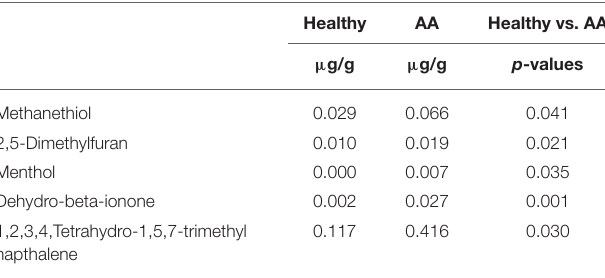
TABLE 2 | Concentrations of VOMs ( µ g/g) in urine samples detected in alopecia areata patients compared to healthy subjects. Healthy AA Healthy vs. AA µ g/g µ g/g p -values Methanethiol 0.029 0.066 0.041 2,5-Dimethylfuran 0.010 0.019 0.021 Menthol 0.000 0.007 0.035 0.002 0.027 0.001 0.117